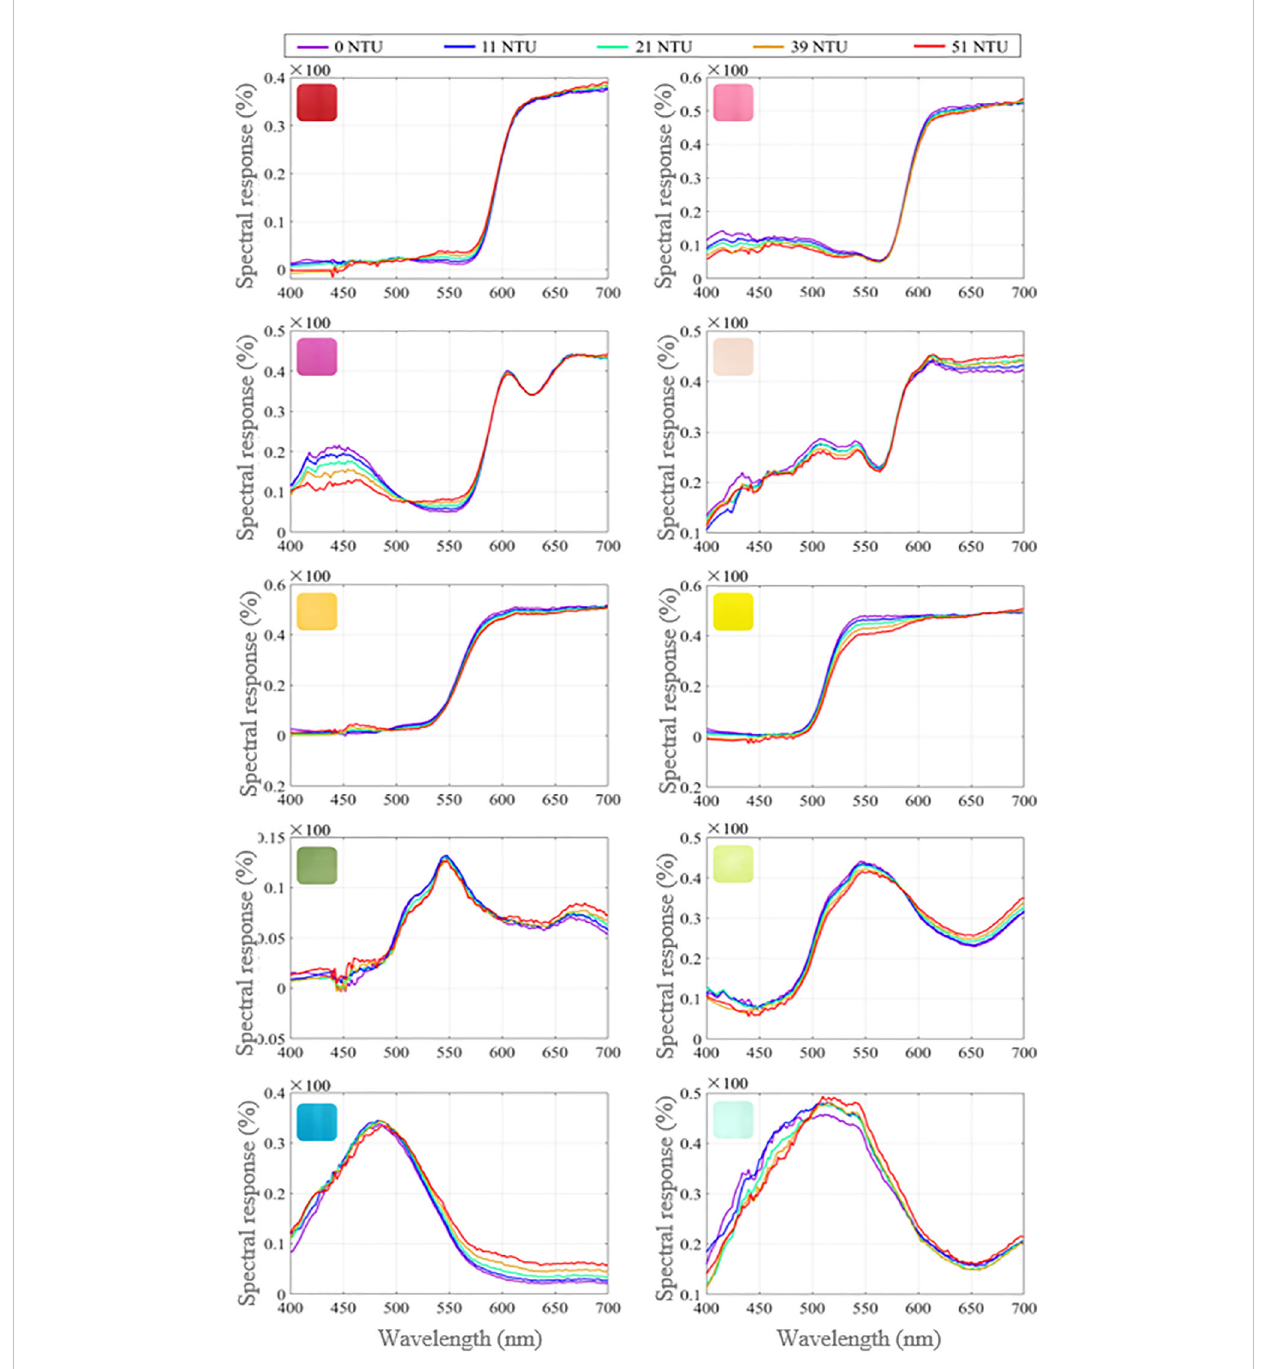
FIGURE 7 Spectral re fl ectance detection of color blocks after the spectral reconstruction process through black and white board correction